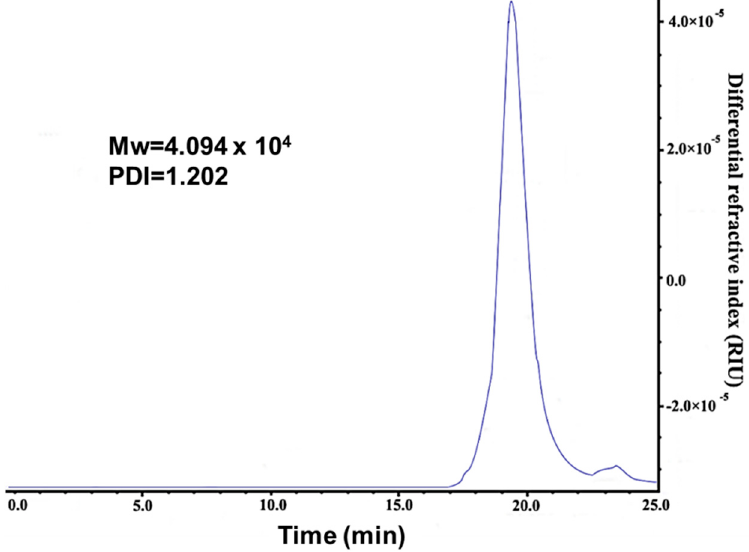
Figure 2. Molecular-weights of synthesized PLL measured by gel permeation chromatography (GPC) using dimethyl formamide (DMF) as the mobile phase.